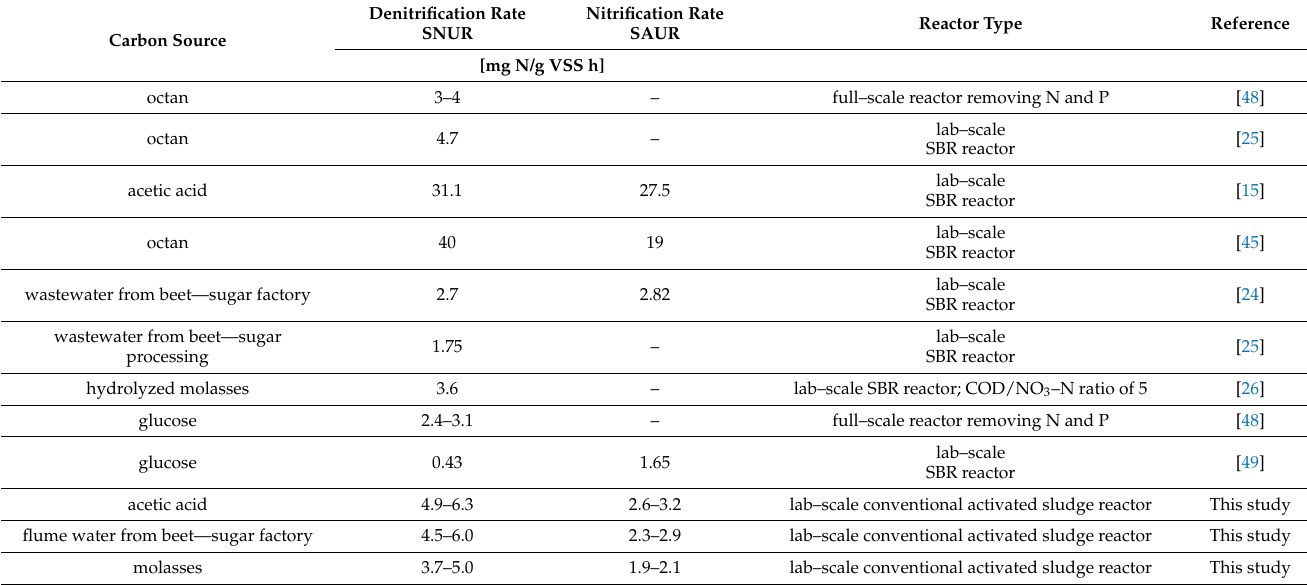
Table 4. Specific denitrification and nitrification rates for different substrates and different reactors type in the literature. Carbon